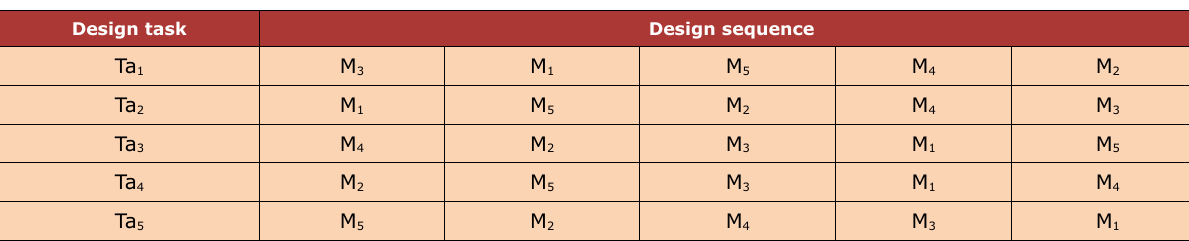
Table 1. Collaborative innovation problems of five design subjects and design tasks